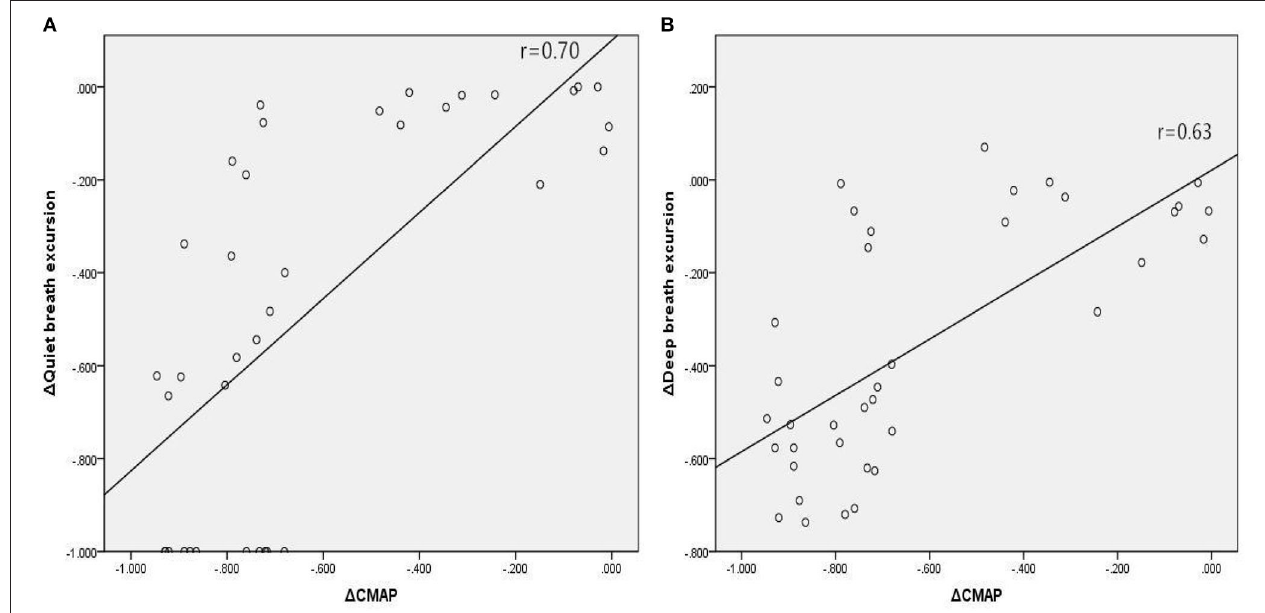
FIGURE 2 | Associations between relative changes ( 1 ) in diaphragm CMAP amplitude and diaphragmatic excursions during quiet breathing (A) and deep breathing (B) before and 30min after SCBPB in Group A. CMAP, compound muscle action potential.